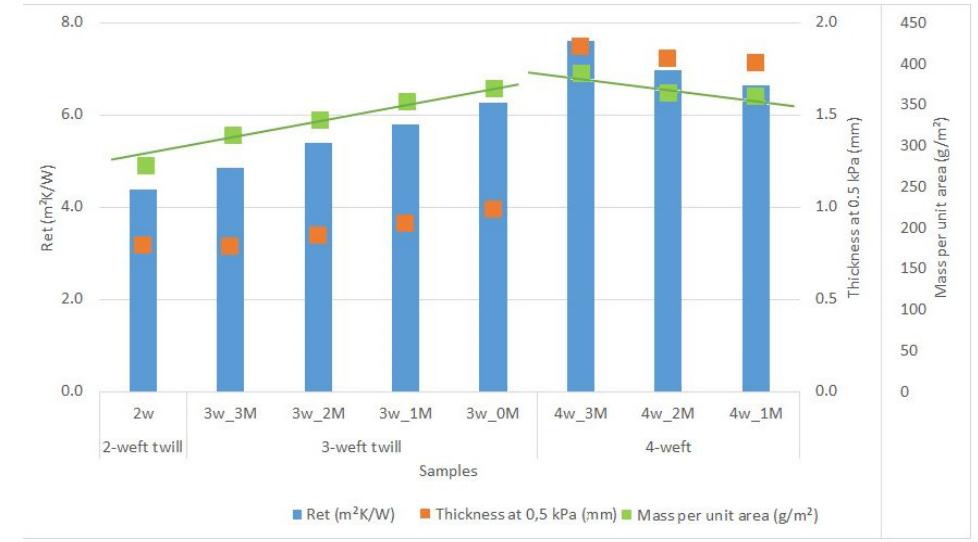
Figure 11. Influence of samples mass and thickness on water-vapor resistance.